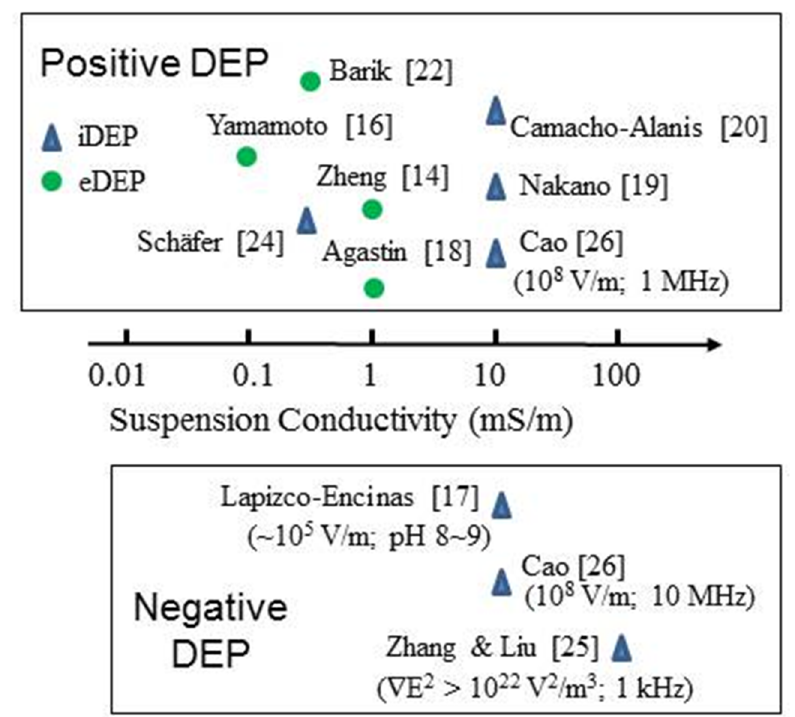
Figure 4. A range of aqueous solvent conductivity has been used in DEP studies of BSA. The experimental factors associated with the two cases [17,25] of negative iDEP and the cross-over of polarity between 1~10 MHz [26] are discussed in Section 2.2.